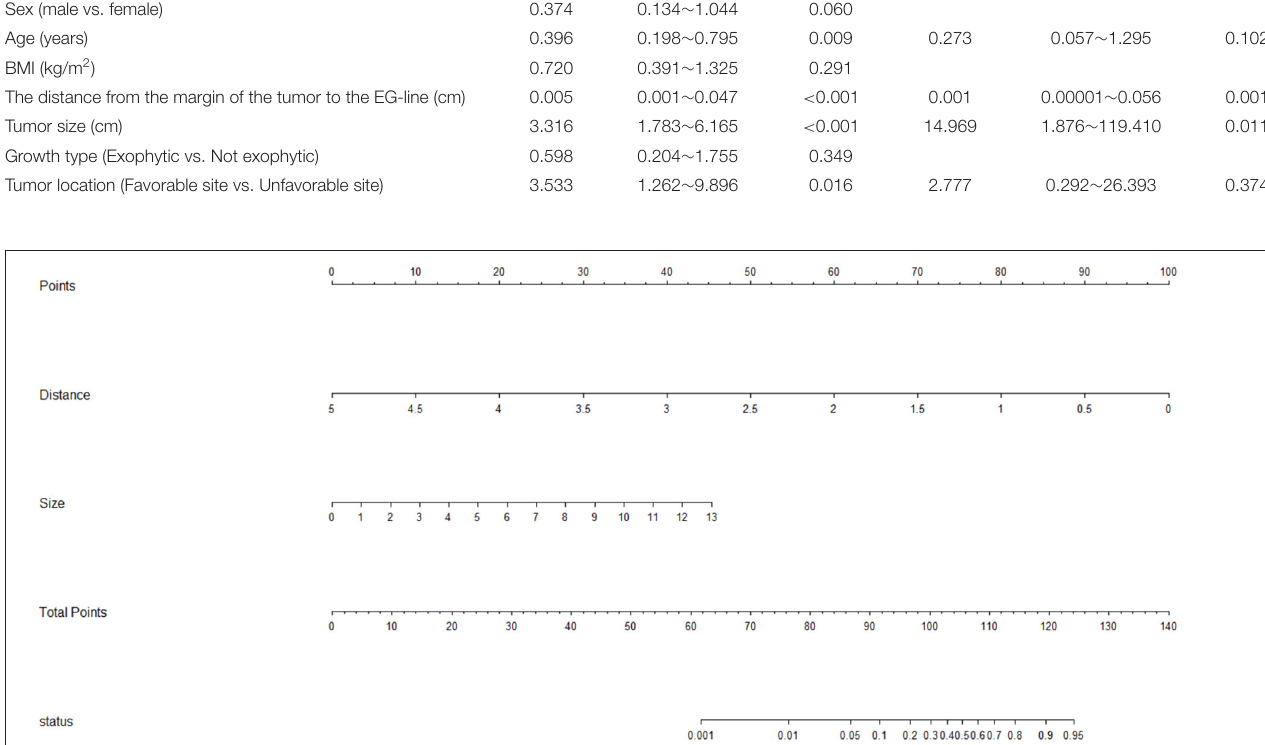
FIGURE 2 | Nomogram for predicting the risk of excising the cardia during laparoscopic surgery for EGJ-GISTs. Distance: Distance from the margin of the tumor to the EG-line (cm); Size: Tumor size (cm); status: probability of EGJ resection.